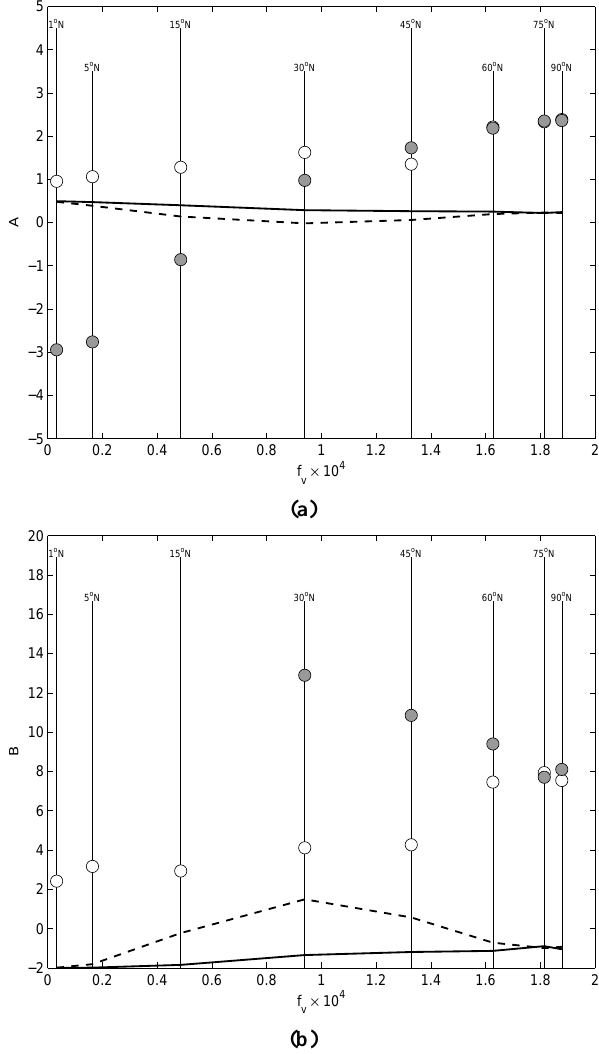
Fig. 5. The parameters A (a) and B (b) of the resistance laws in the EBL. The solid curve is the analytical approximations with h PBL and α for the WE-EBL (dashed line) and the EW-EBL (solid line). Shaded circles show the WE-EBL; open circles, the EW-EBL. The data correspond to hour six of